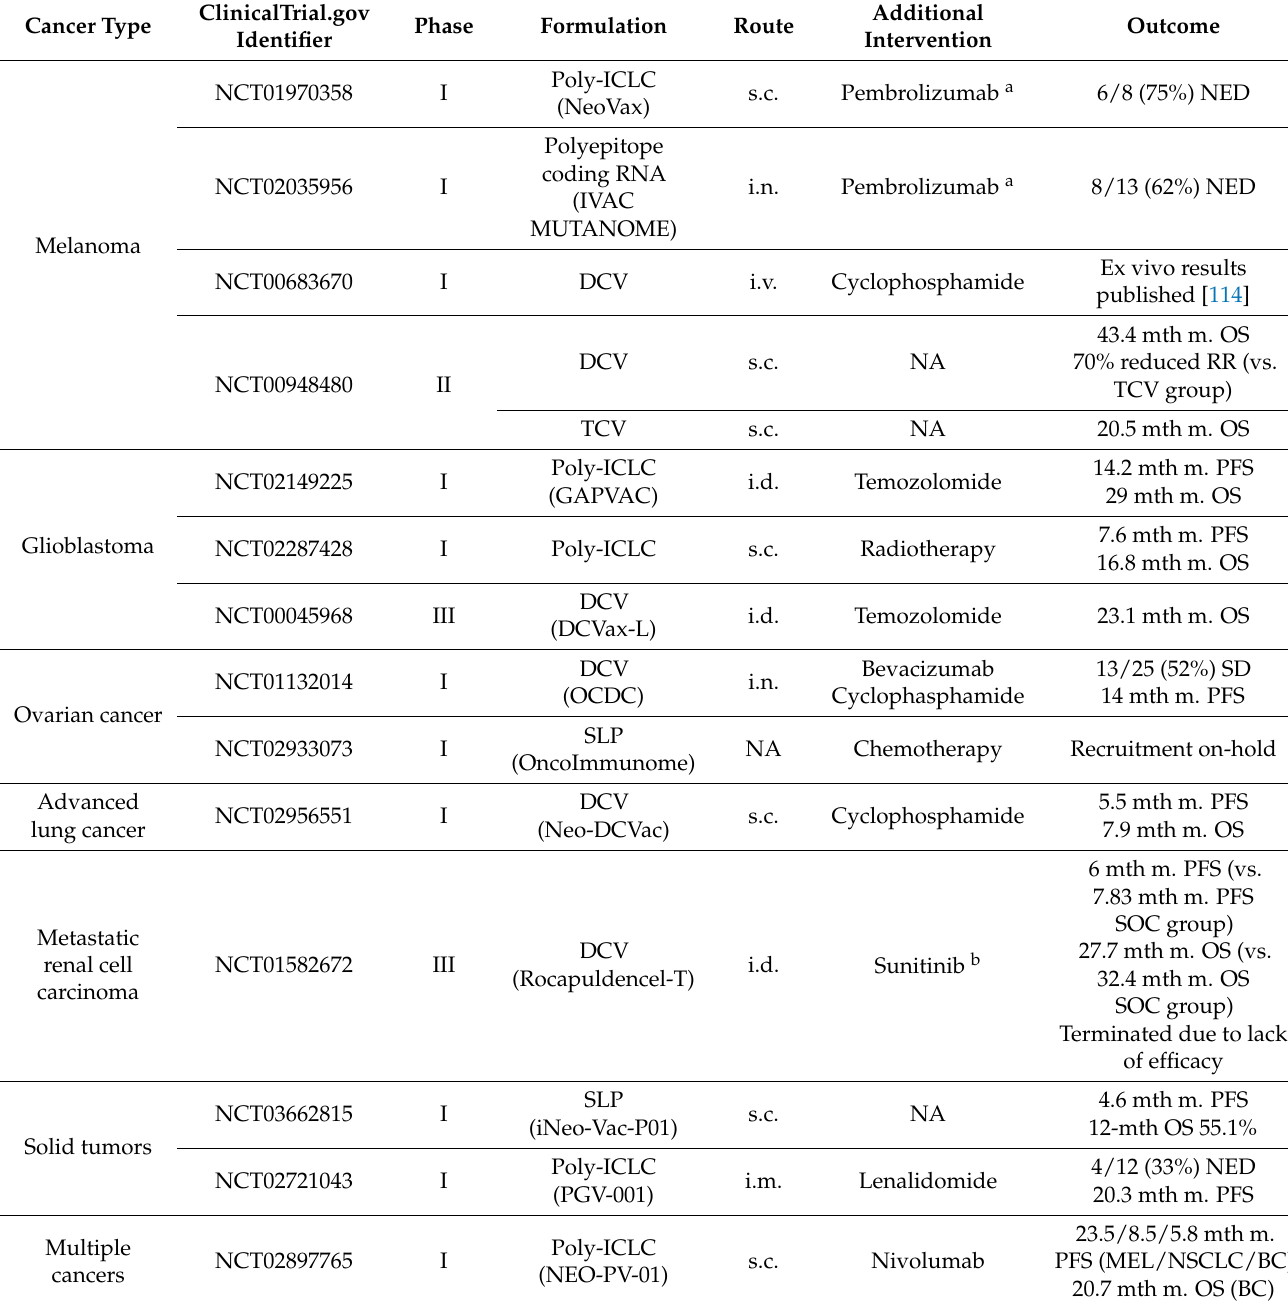
Table 1. Summary of clinical evaluations related to neoantigen